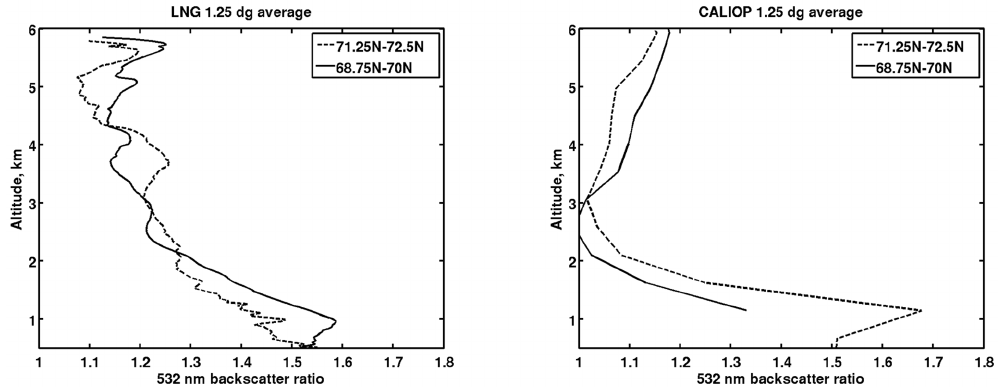
Figure 11. B-LNG lidar (left) and CALIOP (right) vertical profiles of the 532nm backscatter averaged over a 1.25 ◦ latitude band and for the aircraft